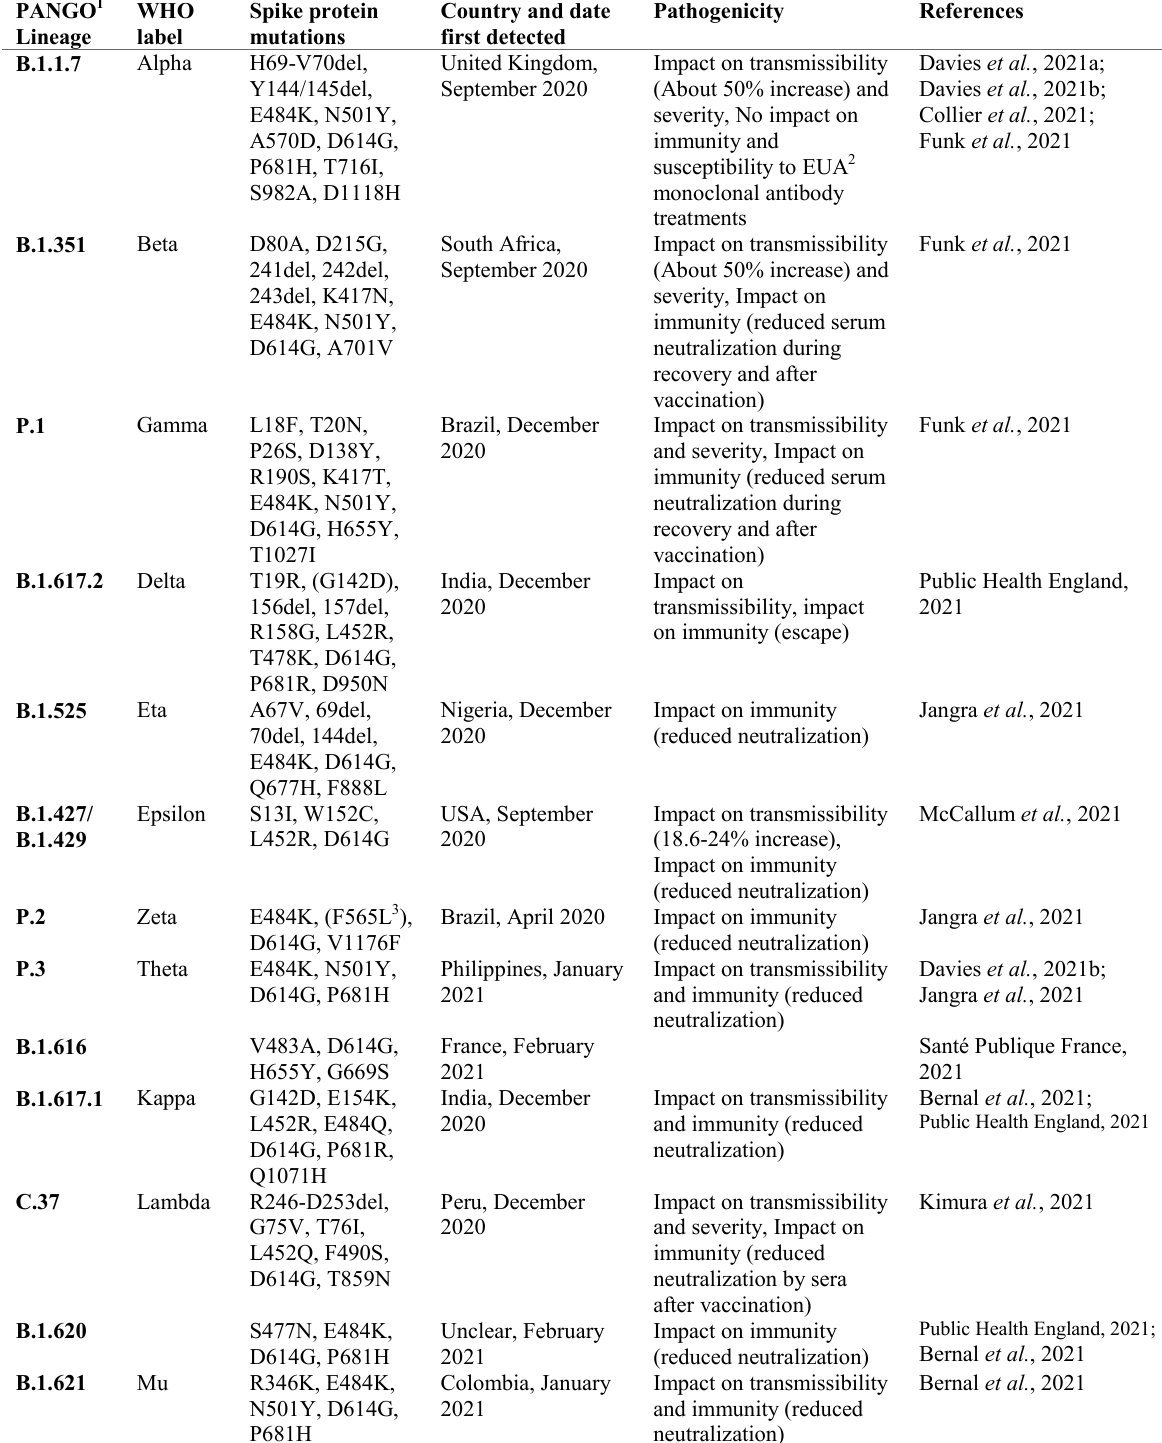
Table 3. SARS-CoV-2 variants of interest and concern. PANGO